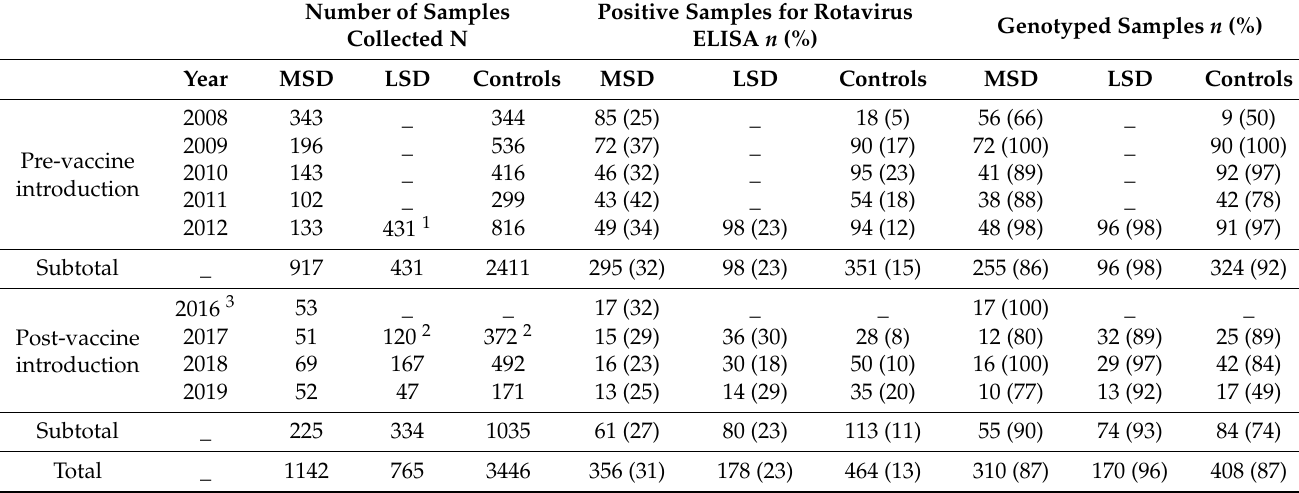
Table 1. Overview of the number of collected stool samples and rotavirus group A detection among cases of MSD, LSD and controls in Manhiça District (Maragra, Manhiça District Hospital,